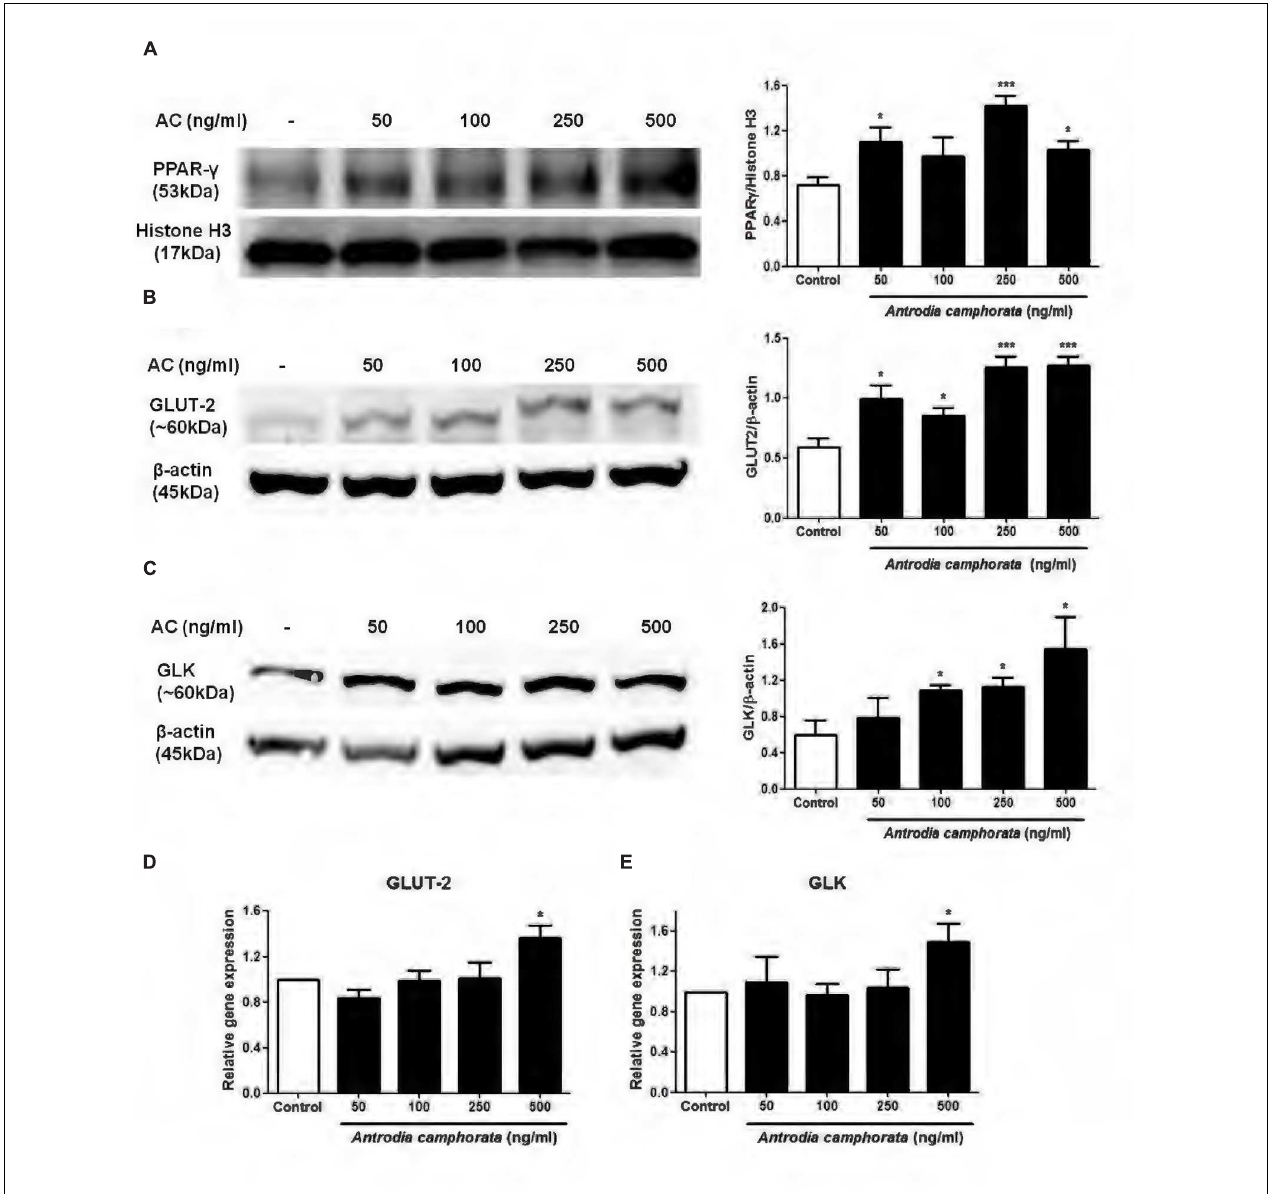
FIGURE 2 | Antrodia camphorata increased PPAR- γ expression and its related protein expressions in MIN6 cells. The cells were treated with A. camphorata (50–500 ng/ml) for 24 h. (A–C) Immunoblots and representative graphs showing the protein expressions of PPAR- γ , GLUT-2 and GLK, n = 4, 5. (D,E) Relative gene expressions of GLUT-2 and GLK. The gene expressions were normalised to control, n = 4, 5. ∗ P < 0.05, ∗∗∗ P < 0.001 vs. control. Results were expressed as mean ±